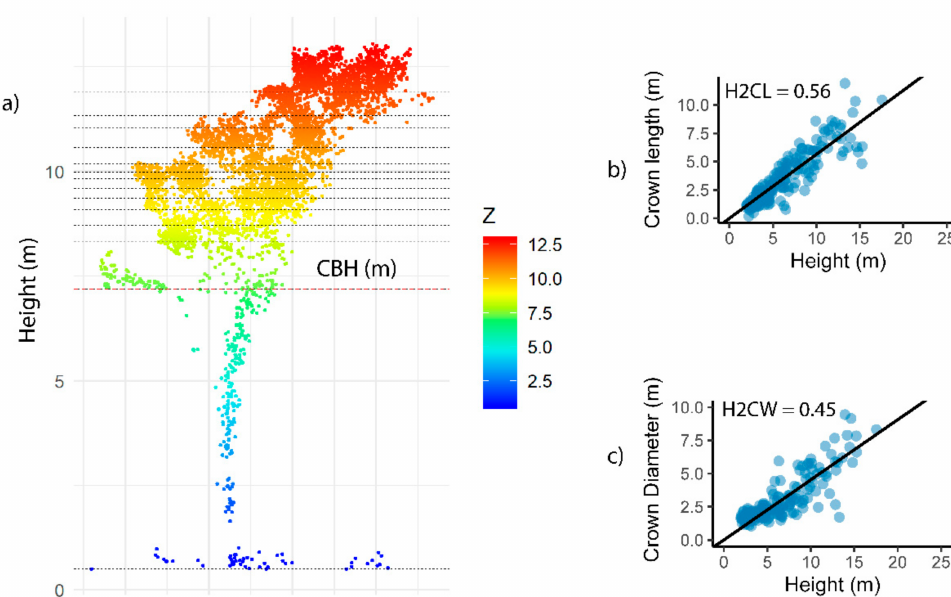
Figure 3. Input parameters for the AMS3D algorithm. ( a ) Crown basal height (red horizontal line) predicted as the upper quantile of the largest gap between 5% quantiles of height. Points from individual crowns were clipped using manually delineated crowns. CBH was subtracted from the highest value to generate crown length. ( b , c ) show the linear models used to derive the AMS3D algorithm parameters; H2CL and